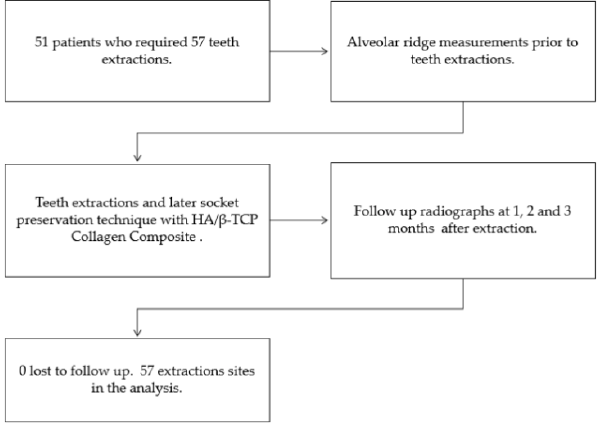
Figure 2. Socket preservation with a composite of hydroxyapatite/ β -tricalcium (HA/ β -TCP) + collagen: flow diagram of the study.